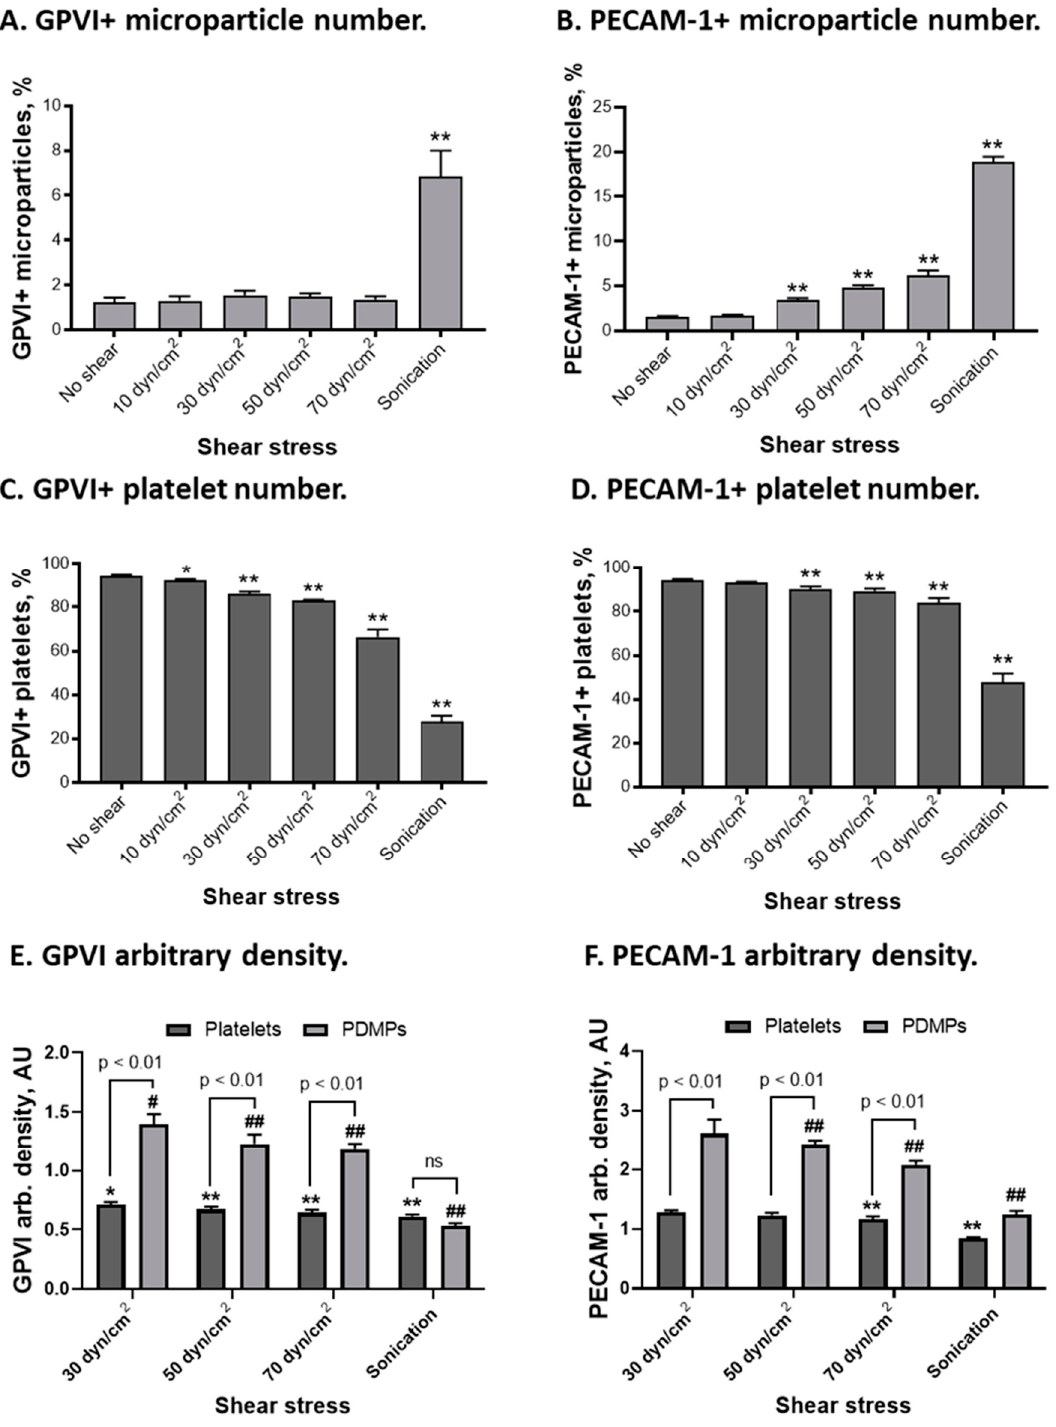
Figure 5. Distribution of GPVI and PECAM-1 receptors on platelets and platelet-derived micropar- ticles (PDMPs): ( A , B )—GPVI+ and PECAM-1+ PDMP number, ( C , D )—GPVI+ and PECAM-1+ plate- let number, ( E , F )—arbitrary density of GPVI and PECAM-1 on platelets and PDMPs. n = 6–7. Mean ± SEM, 1-way ANOVA followed by Dunne tt multiple comparisons test: *, #— p < 0.05 and **, ##— p < 0.01 vs. no shear for platelets and PDMPs.